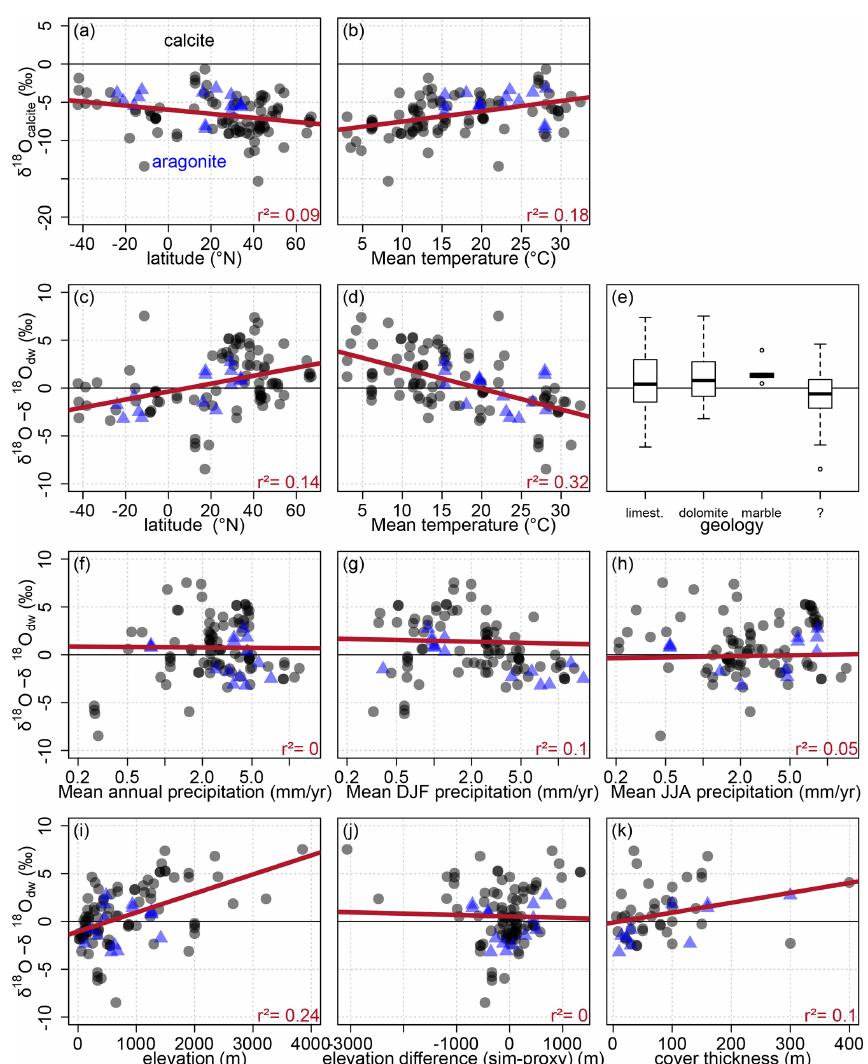
Figure 4. Systematic comparison of climate variables from LM1 and cave parameters on δ 18 O dw . eq and the offset (cid:49)δ 18 O to the simulation. Shown are the absolute values of δ 18 O dw . eq vs. (a) site latitude and (b) simulated local annual mean temperature, and the model–data difference vs. (c) latitude, (d) simulated mean annual temperature, (e) geology surrounding the cave (“?” means unknown geology), and (f) mean annual precipitation amount from (g) DJF and (h) JJA as well as (i) cave elevation, (j) the elevation difference between the model grid and actual cave, and (k) the overall cover thickness above the cave. Symbols denote calcite (black circles) or aragonite (blue triangles) specimens. An unweighted linear regression (red line) is added for illustration, but without consideration of significance.